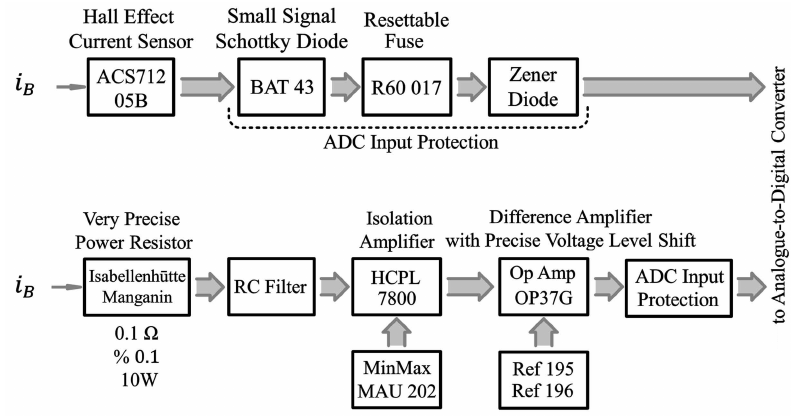
Figure 8. Two common circuits to measure current in a converter.